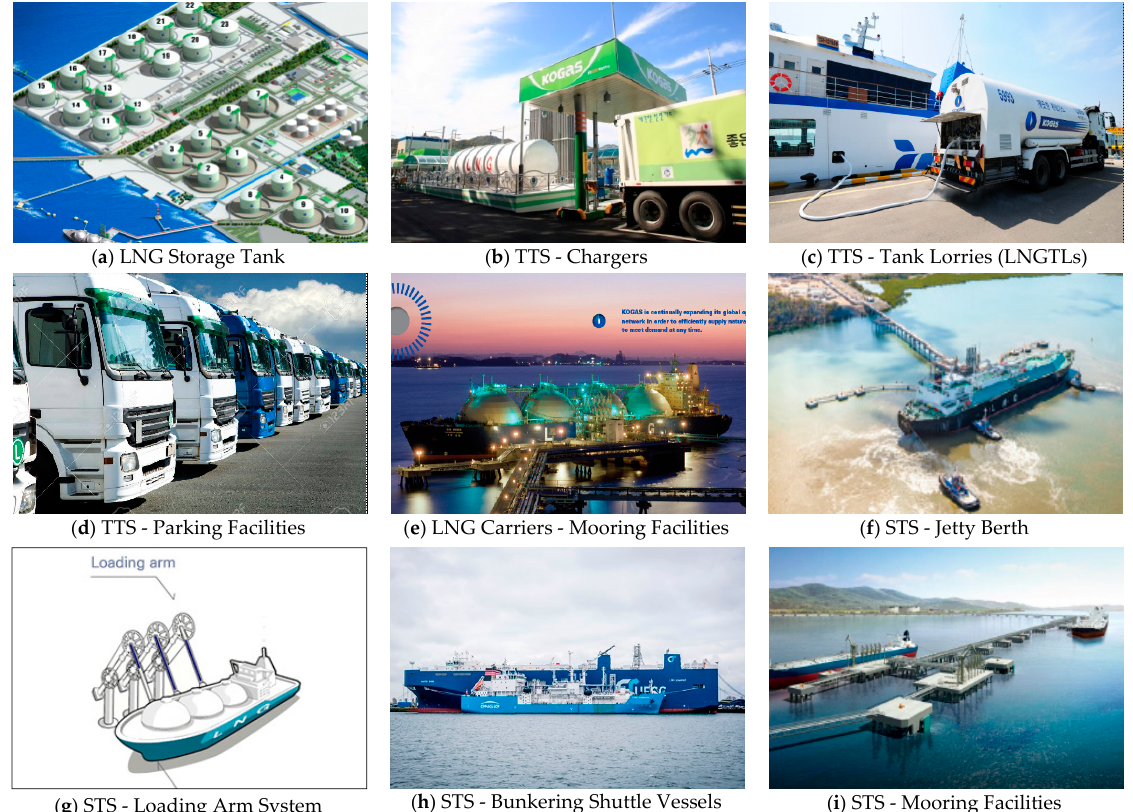
Figure 10. Reprinted the Photos of LNG Bunkering Port Facilities under Permission of Korea Gas Corporations (modified from ref. [36]).